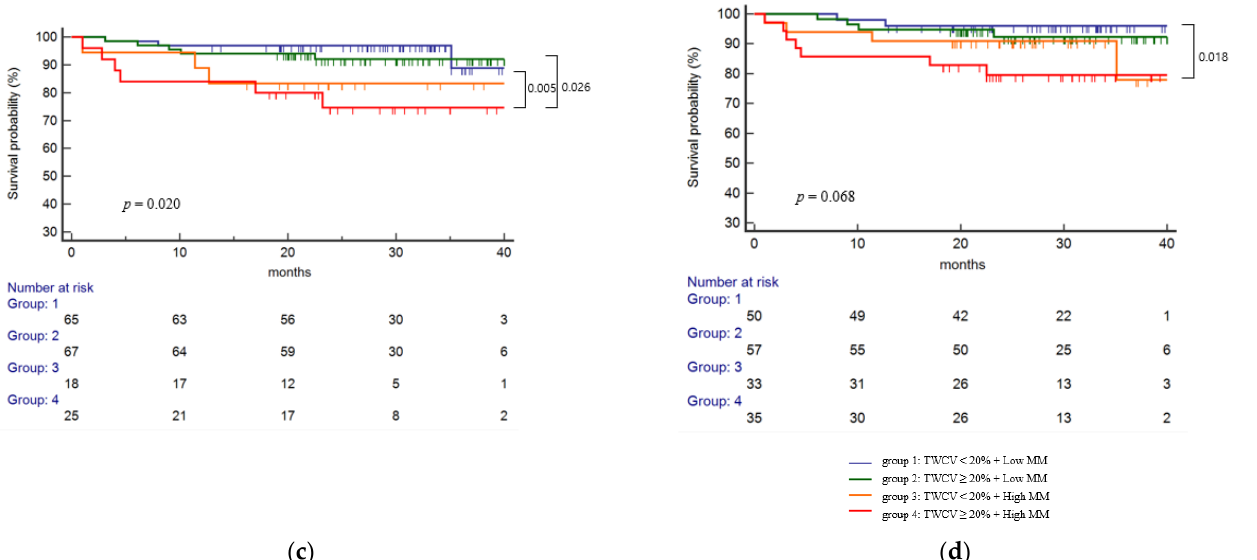
Figure 5. Combined effects of eplet mismatch and TAC-IPV on the risk of class II dnDSA development. ( a ) Combined effects of single molecular eplet mismatch and TAC-IPV (cut off: 20%) for the risk of class II dnDSA development showed higher dnDSA-free survival in group 1 compared to groups 3 and 4, and group 2 compared to groups 3 and 4, ( b ) total eplet mismatch and TAC-IPV for the risk of class II dnDSA development showed higher dnDSA-free survival in group 1 compared to groups 2, 3 and 4, and worse dnDSA-free survival in group 3 compared to group 2, ( c ) antibody-verified eplet mismatch and TAC-IPV for the risk of class II dnDSA development showed higher dnDSA-free survival in group 1 and 2 compared to group 4, ( d ) antibody-verified single molecular eplet mismatch and TAC-IPV for the risk of class II dnDSA development showed higher dnDSA-free survival in group 1 compared to group 4 ( p < 0.001, p < 0.001, p = 0.005, p = 0.068 respectively). TAC-IPV, tacrolimus intrapatient variability (TAC-IPV); TWCV, time-weighted coefficient of variability; low MM, low and intermediate eplet risk groups combined; high MM, high eplet risk group